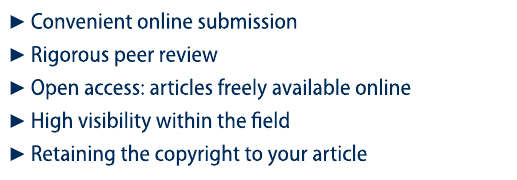
treatment cycle: impact on ovarian stimulation. A pilot study. Fertil Steril 95(5):1714 – 1719.